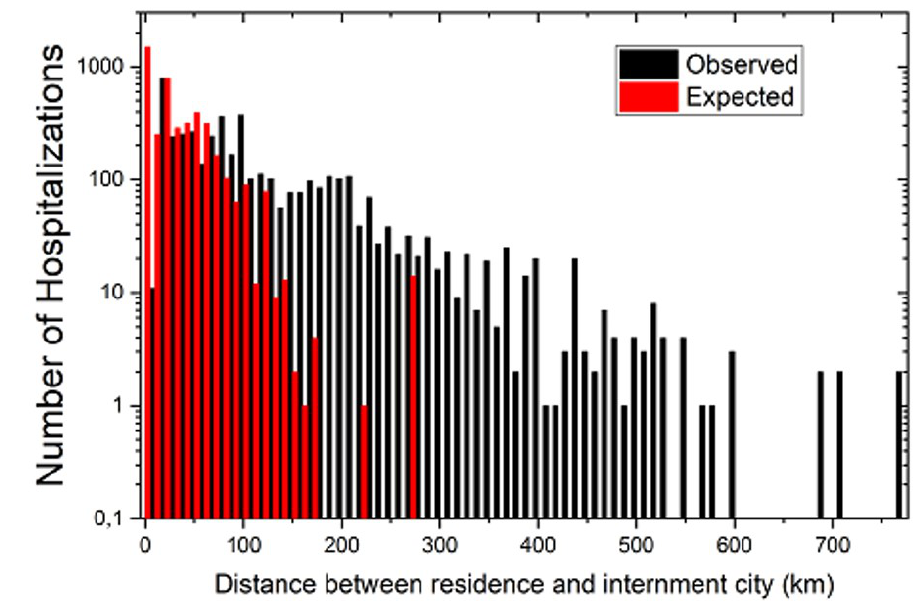
Figure 2. A histogram with the frequencies of expected (red) and observed (black) distances traveled by COVID-19 patients. Source: Author.